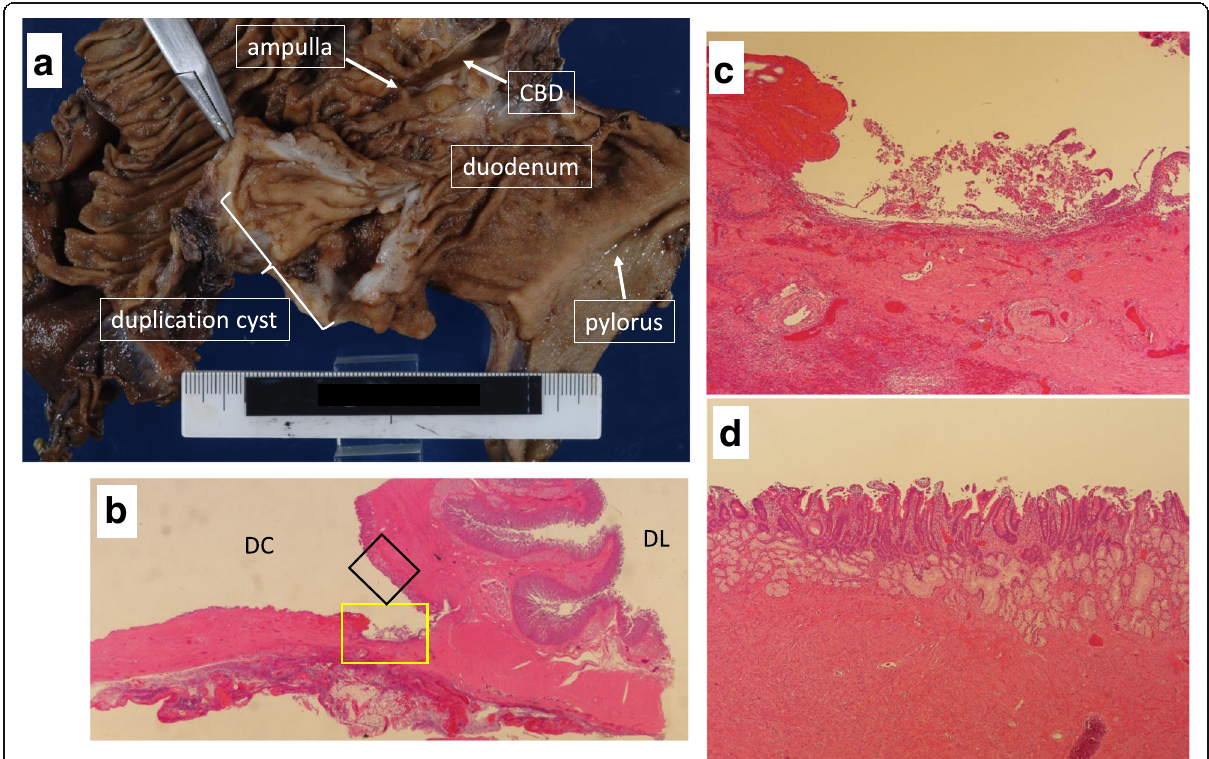
Fig. 3 a Macroscopically, a cystic mass of 5 cm in size was adjacent to the second part of the duodenum on the pancreas side and was close to the ampulla. b Microscopically, the wall of the cyst was composed of gastric mucosa and shared a common proper muscle layer with the duodenum. DL indicates the side of the duodenal lumen, and DC indicates the side of duplication cyst (H&E × 1.1). c Magnified view of the yellow frame area in b . Chronic ulcers and erosions were seen in the cyst (H&E × 40). d Magnified view of the black frame area in b . Ectopic gastric mucosa was observed in non-ulcerative region (H&E ×